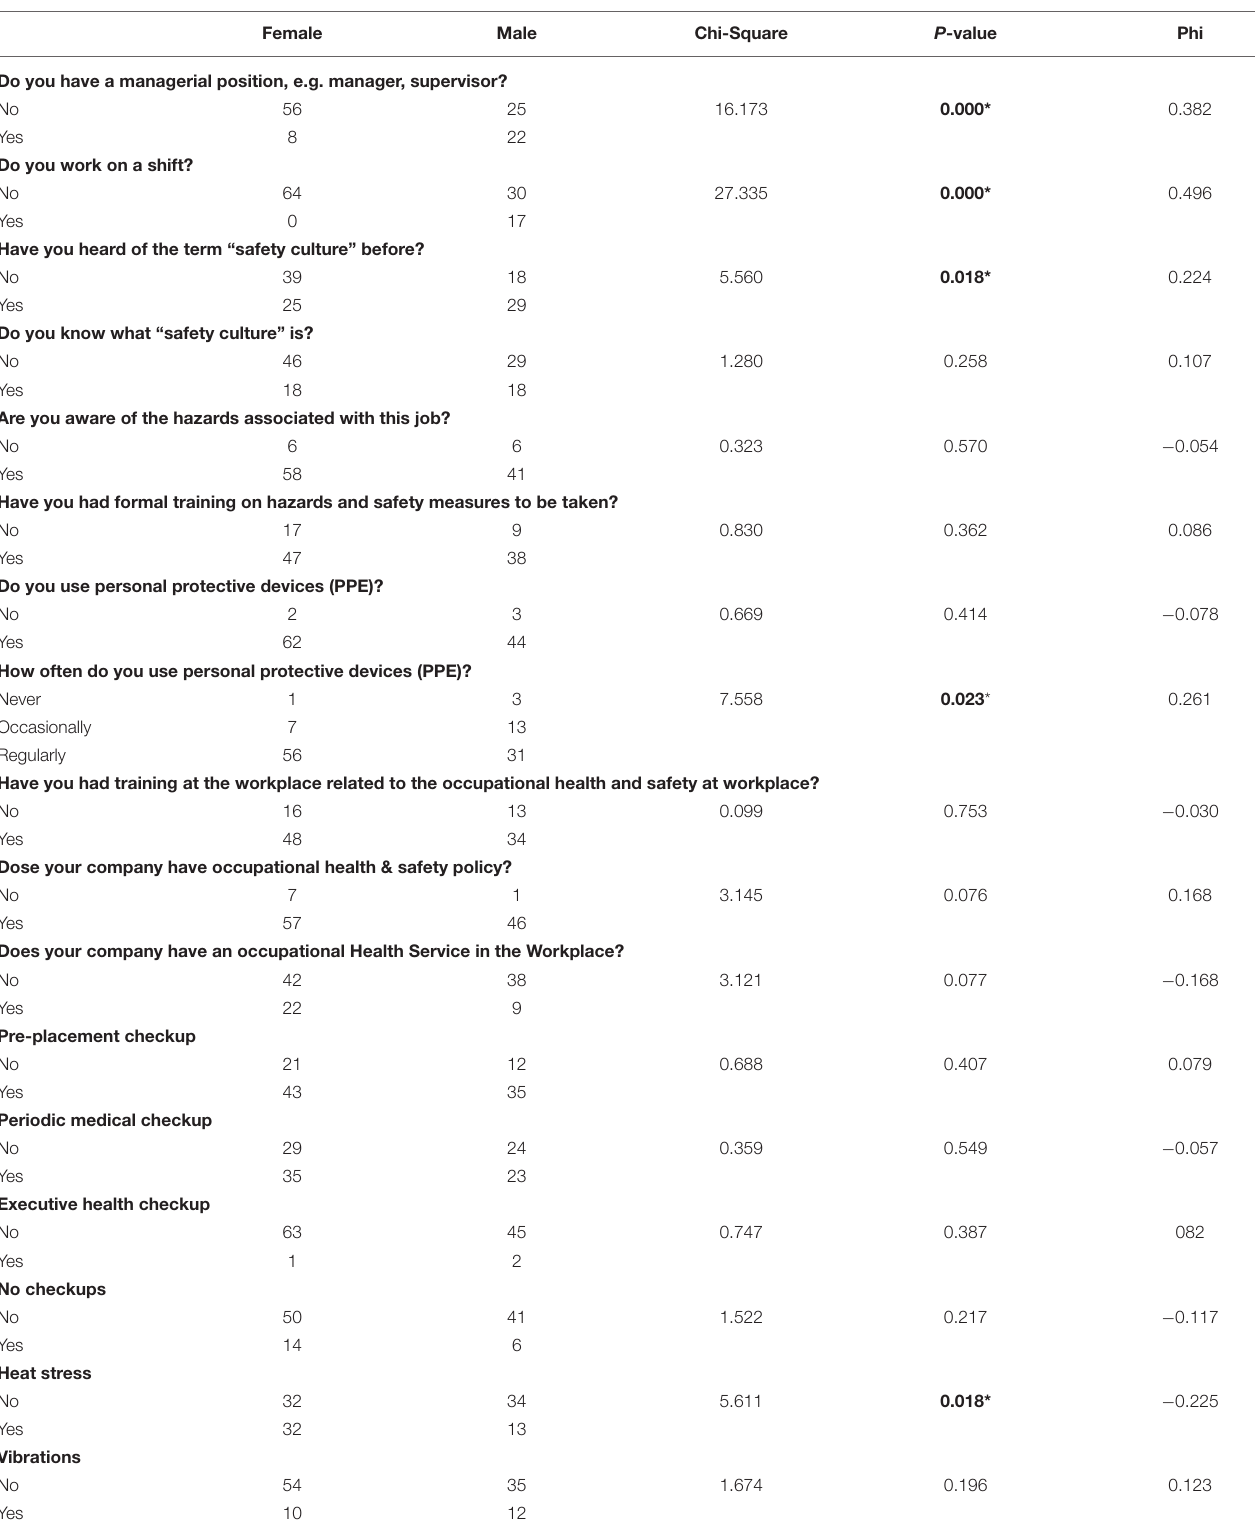
TABLE 4 | Gender differences among workers regarding occupational hazards. Female Male Chi-Square P -value